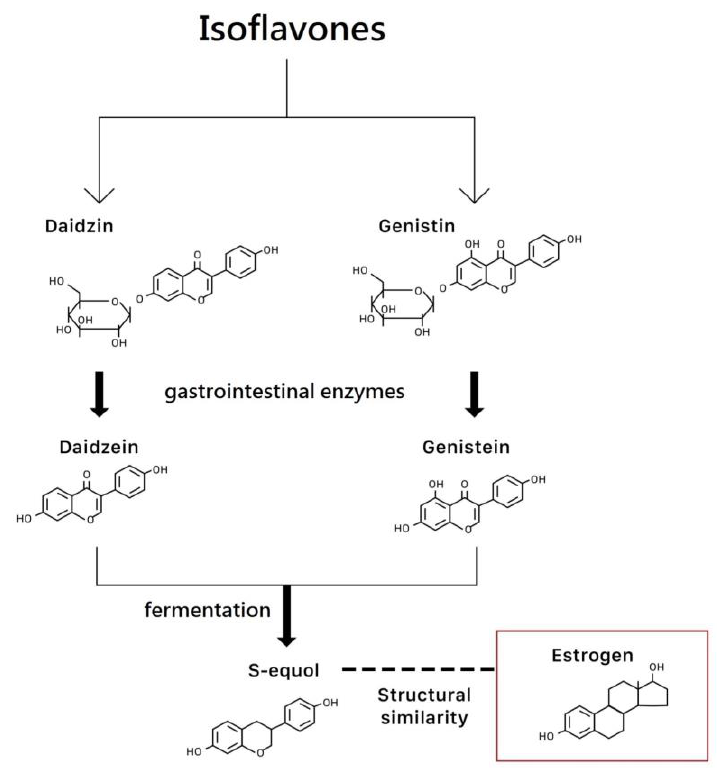
Figure 2. The chemical structures of isoflavones including daidzin and genistin and their derivatives daidzein, genistein and S-equol (structurally similar to estrogen) .